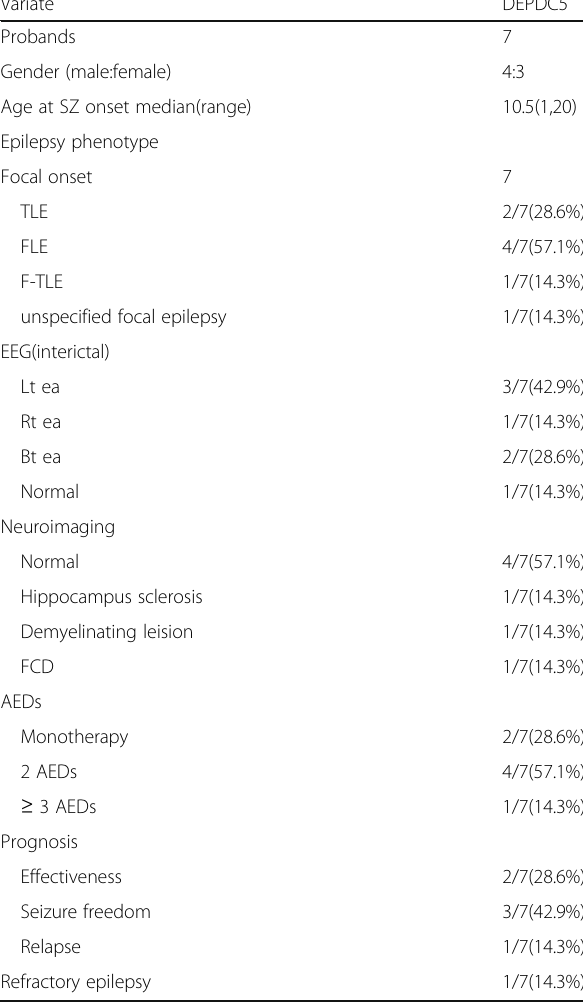
Table 3 Sum-up of clinical data of the patients